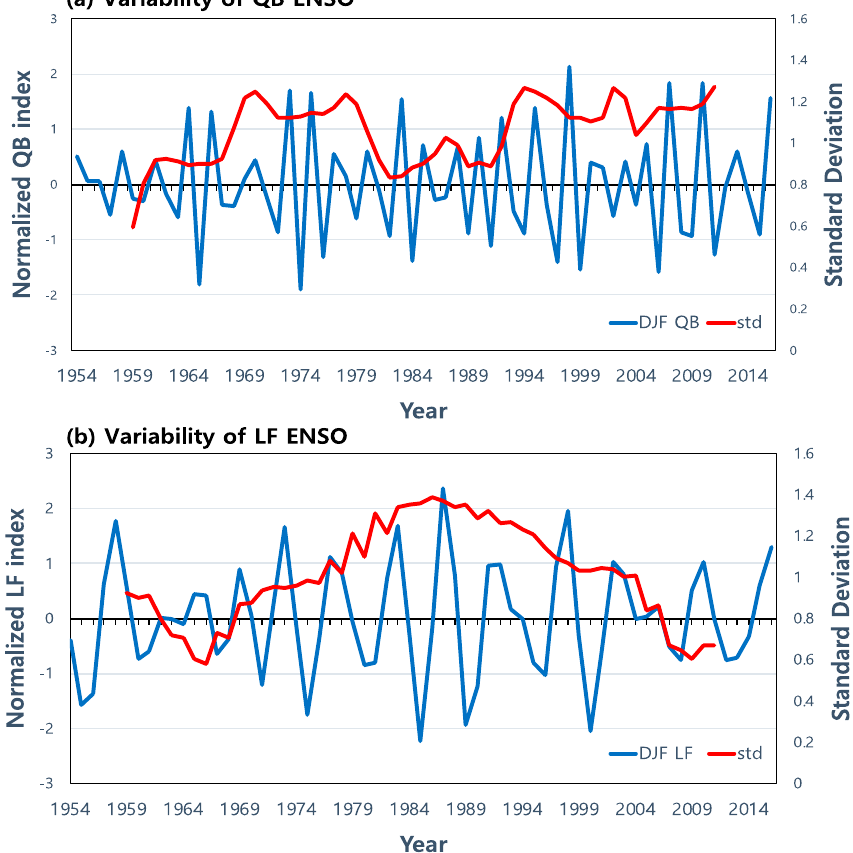
Figure 9. Interannual variability of (a) QB- and (b) LF-type ENSO. The blue line indicates the wintertime QB- and LF-type ENSO indices and the red line is the 11-year running standard deviation of indices.